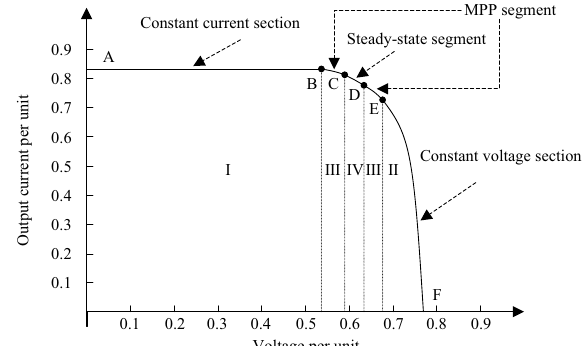
Figure 6. I–U characteristic curve interval division